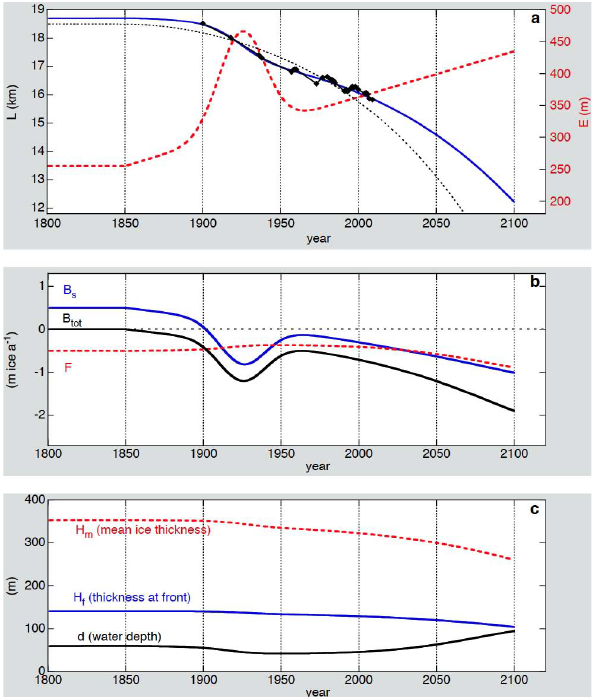
Fig. 6. (a) Simulated glacier length (blue), observations (black dia- monds), and inferred equilibrium line altitude (red, dashed) for the calibration run. The corresponding components of the mass budget are shown in (b) and ice thickness and water depth at the front in (c) . Note that the components of the mass budget have been divided by the length of the glacier to obtain the dimension of a mean balance rate. The black dotted line in (a) shows the best possible simulated glacier length if E 2 = 0, i.e. when the equilibrium line altitude is forced to increase linearly in